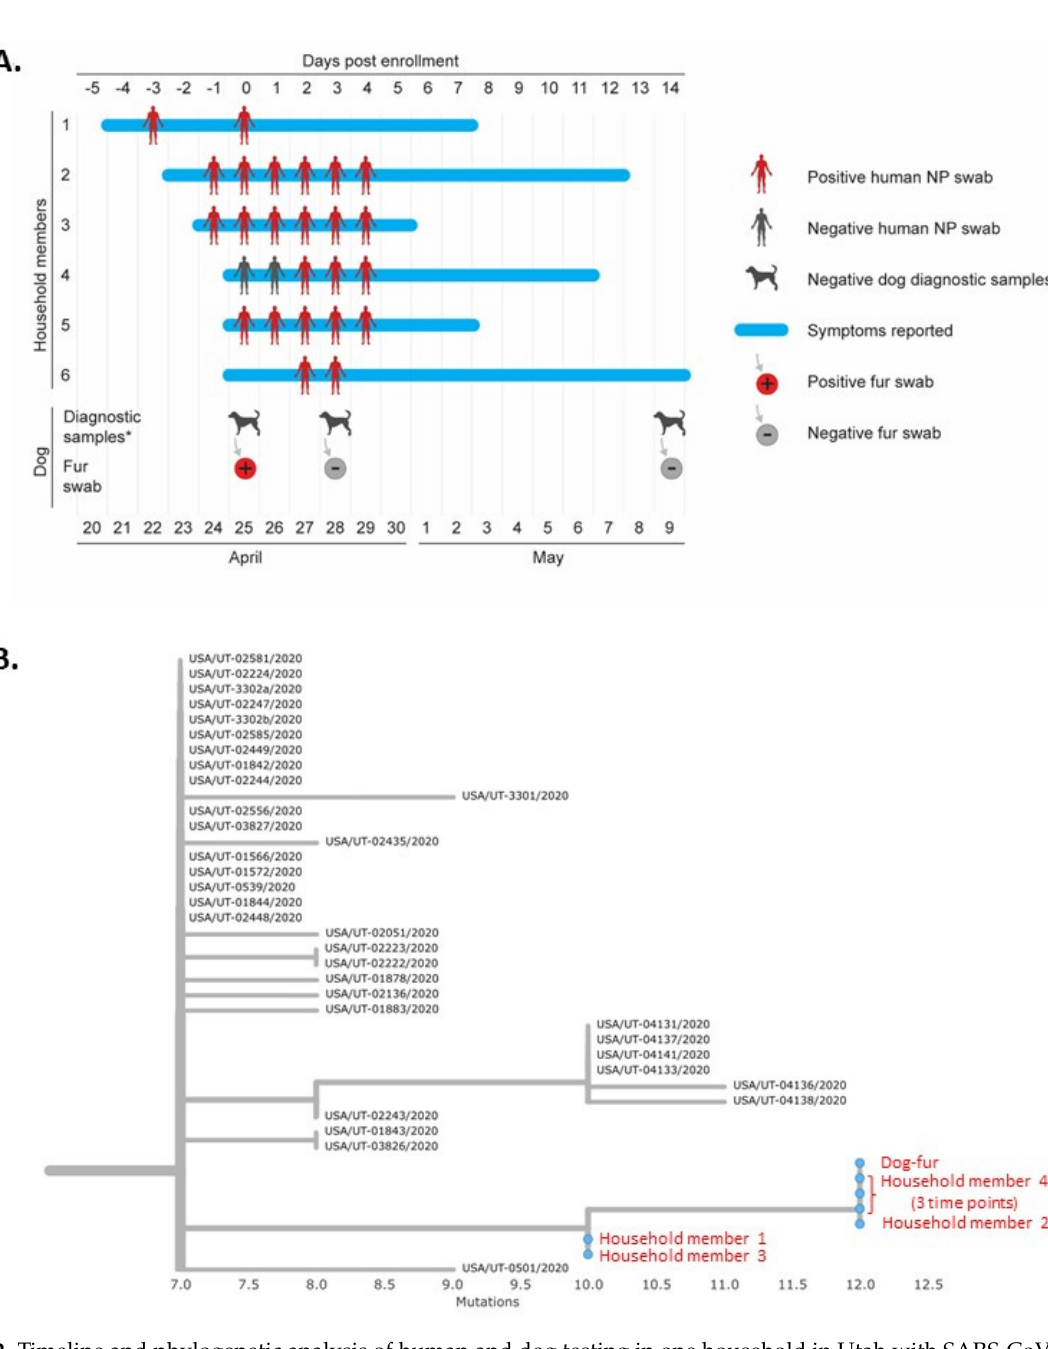
Figure 2. Timeline and phylogenetic analysis of human and dog testing in one household in Utah with SARS-CoV-2 RNA detected on the dog’s fur, One Health COVID-19 Household Transmission Investigation, April–May 2020. ( A ) Timeline of human and dog testing in one household in Utah with six persons with laboratory-confirmed COVID-19 and SARS-CoV-2 RNA detected on the dog’s fur. The timeline indicates dates of reported symptoms and results of nasopharyngeal swab testing by rRT-PCR in human COVID-19 cases and samples collected from the dog in the household. Diagnostic samples * from the dog included oral, nasal, and rectal swabs and stool, which all tested negative by rRT-PCR, and a blood sample which was negative by virus neutralization. ( B ) Enhanced view of branch-tip from comprehensive phylogram (Figure S2), depicting here the seven study sequences (red) alongside selected Utah complete genome sequences available from Global Initiative on Sharing All Influenza Data. Branch length is by divergence. See Figure S2 for zoomed-out dendrogram depicting additional available sequences from